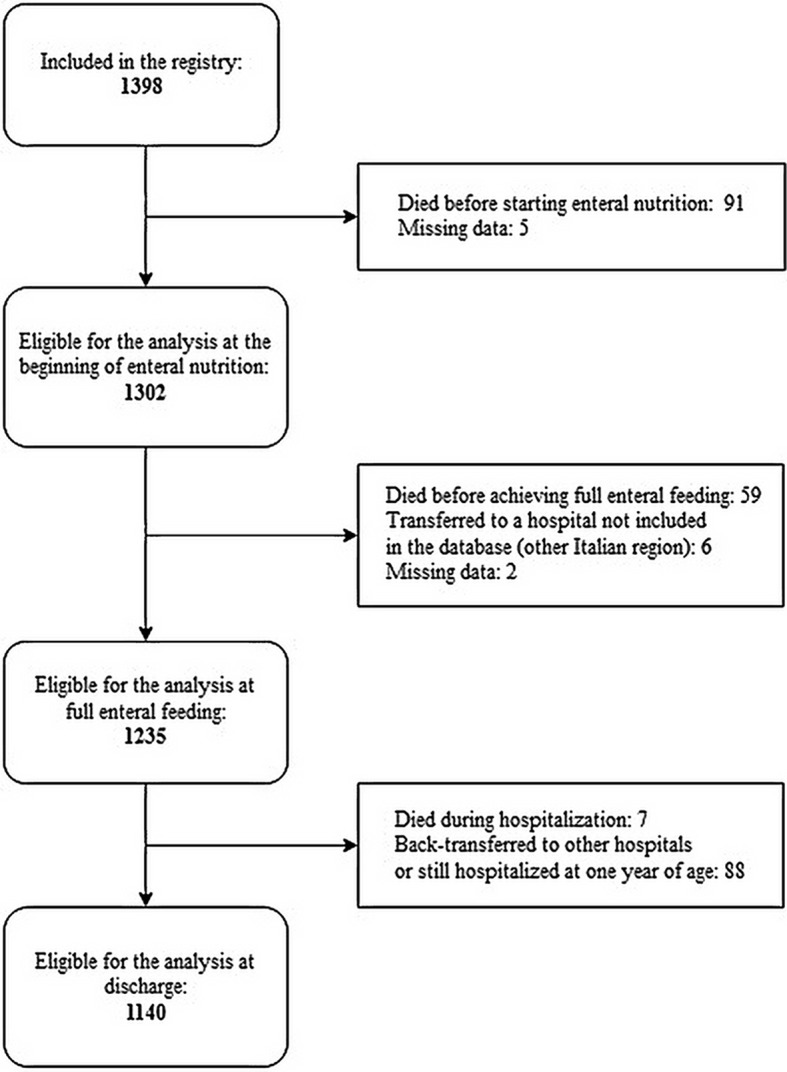
Study population.